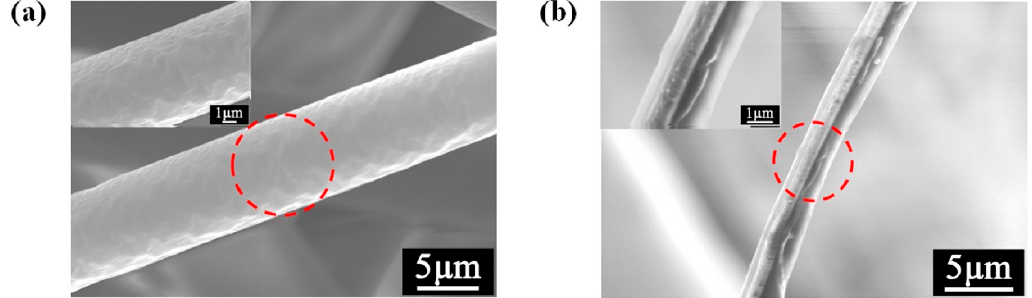
Figure 8. SEM images of ( a ) PP and ( b ) PC-5 meltblown membranes. Table 4. Roughness parameters of the investigated samples （ R a –average roughness, R q –root mean square).